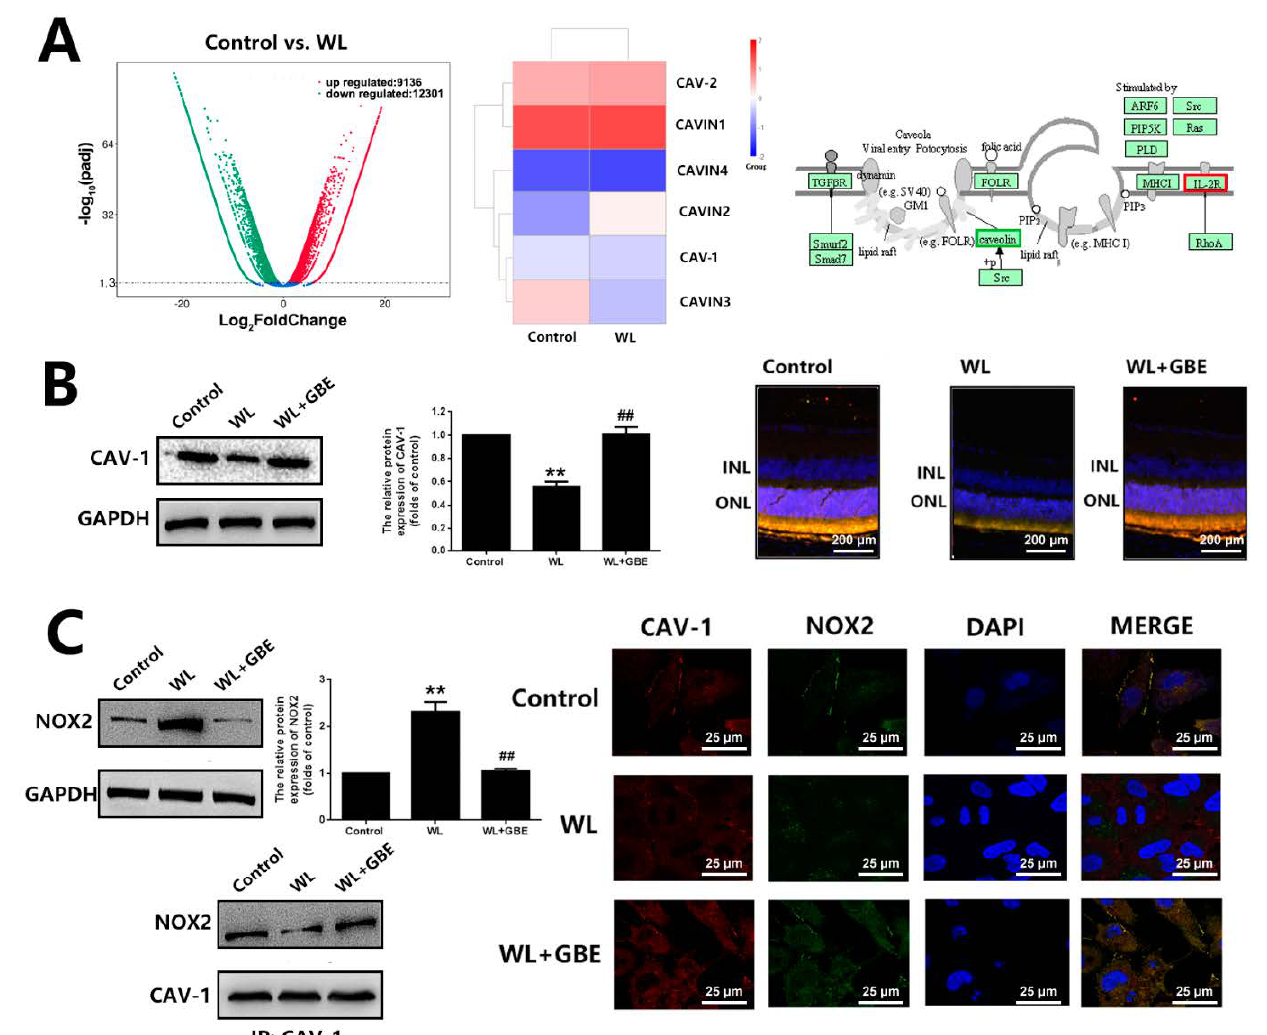
Figure 5. The influence of GBE on CAV-1 expression and CAV-1-NOX interaction in 661W cells and C57BL/6J mice exposed to WL illumination. ( A ) Transcriptome sequencing was performed on 661W cells pre-treated with or without GBE (100 mg/L, 24 h) exposed to WL (4000 lux) for 2 h. Volcano plots of the differentially expressed genes (DEGs) (left panel). Heatmap analysis of significantly changed caveolae-related genes (middle panel). KEGG pathway enrichment analysis of caveolae-related genes (right panel). ( B ) The 661W cells pre-treated with GBE (100 mg/L 24 h) were exposed to WL (4000 lux) for 2 h, and the expression of CAV-1 was assessed by Western blot analysis (left panel). The relative expression of CAV-1 is shown in the middle panel. Retinal tissues from mice with the indicated treatments were co-stained with DAPI (blue fluorescence), CAV-1 (red fluorescence) and rhodopsin (green fluorescence) (right panel). ( C ) The influence of GBE on NOX2 expression is shown in the left upper panel; the densitometry analysis of protein expression is shown in the right upper panel. CAV-1-NOX2 interaction was evaluated by co-immunoprecipitation (bottom-left panel). The protein lysate was pulled down by anti-CAV-1 antibody and then the samples were detected with anti-NOX2 antibody. The co-localization of CAV-1 (red fluorescence) and NOX2 (green fluorescence) was indicated with immunofluorescence staining (right panel). ** p < 0.01 vs. Control, ## p < 0.01 vs. WL. WL: white light, INL: inner nuclear layer, ONL: outer nuclear